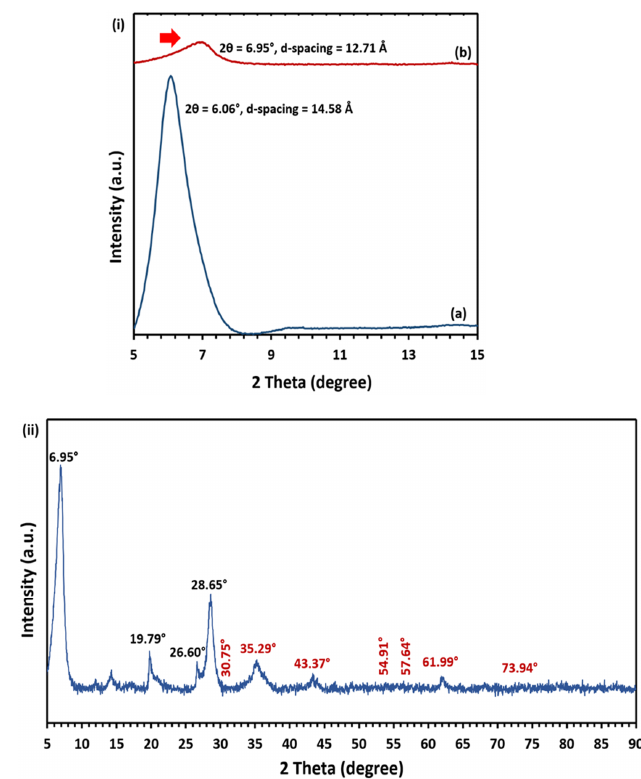
Figure 2. ( i ) XRD patterns of (a) pristine MMT and (b) MMT/CR/Fe 3 O 4 -NCs at 2θ = 5° to 15°, red arrow shows the right shift of the peak; ( ii ) full XRD pattern of MMT/CR/Fe 3 O 4